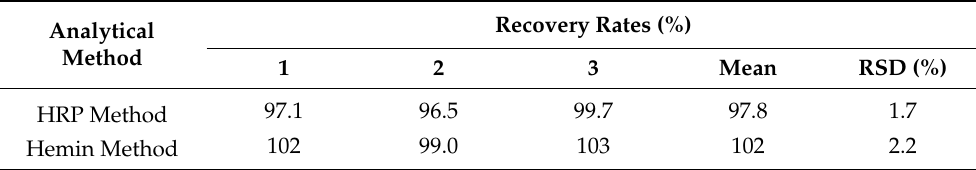
Table 6. Recovery rates of H 2 O 2 by two